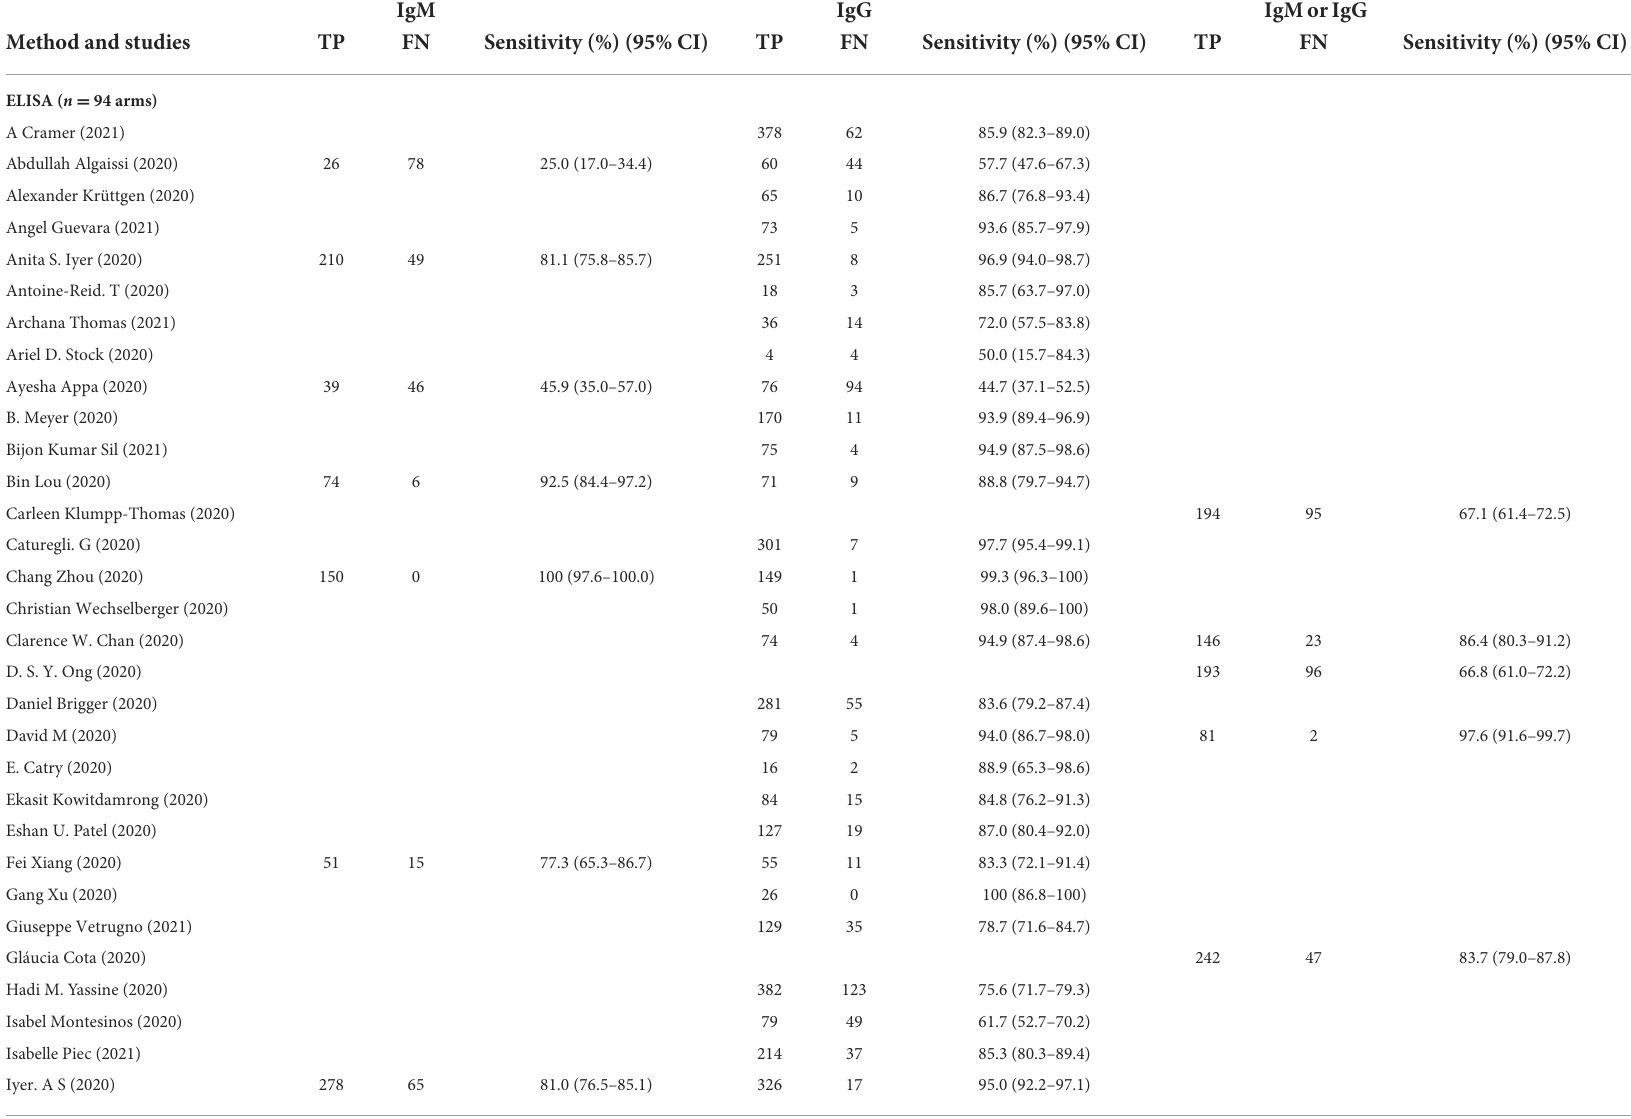
TABLE 2 Individual and pooled sensitivity by serological test method and immunoglobulin class